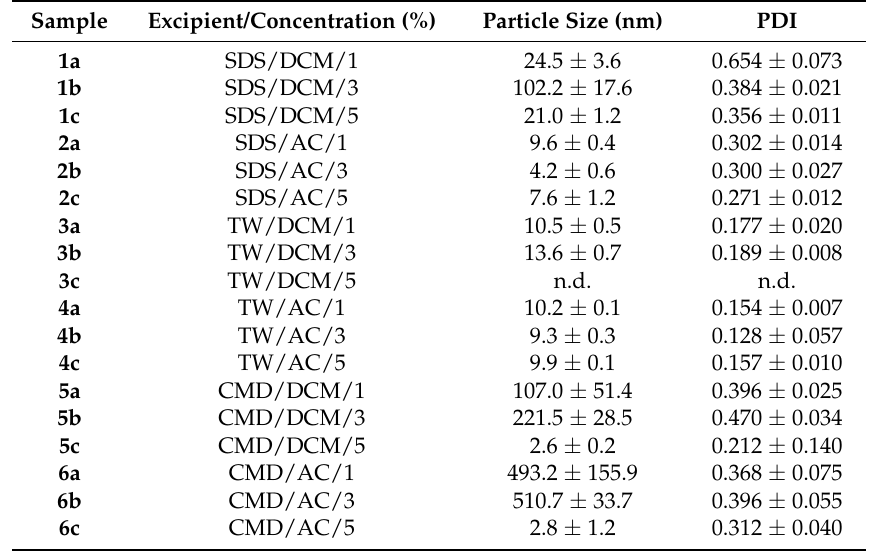
Table 1. Composition of samples (dichloromethane Series 1, 3, 5; acetone Series 2, 4, 6), concentration (%) of individual excipients in water samples relative to hydrochlorothiazide, particle size (nm) and polydispersity index (PDI) of hydrochlorothiazide samples expressed as mean ± SD ( n = 5 independent measurements). (SDS = sodium dodecyl sulfate, TW = Tween 80, DCM =